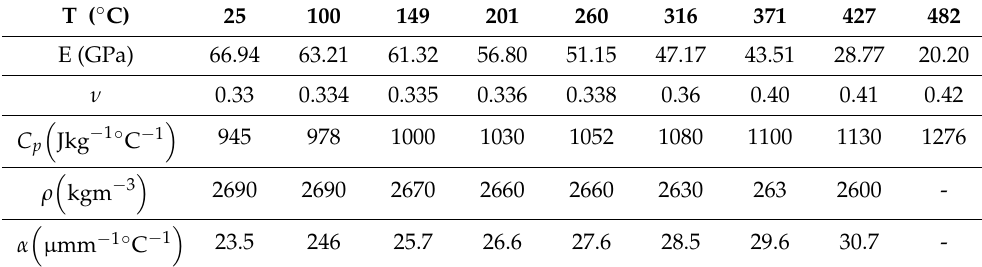
Table 6. The thermo–mechanical properties of AA6061 [26].